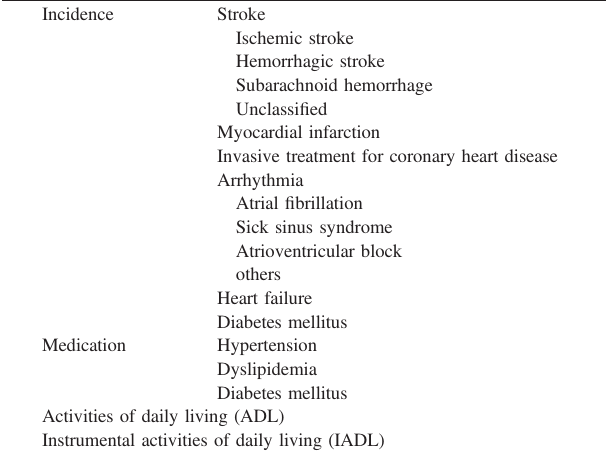
Table 2. Main outcome measures: NIPPON DATA2010